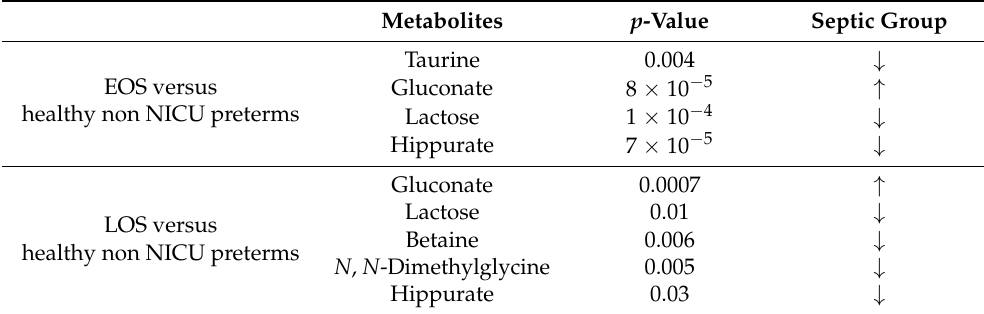
Table 2. Statistically significant metabolites and their p -value for EOS and LOS groups.